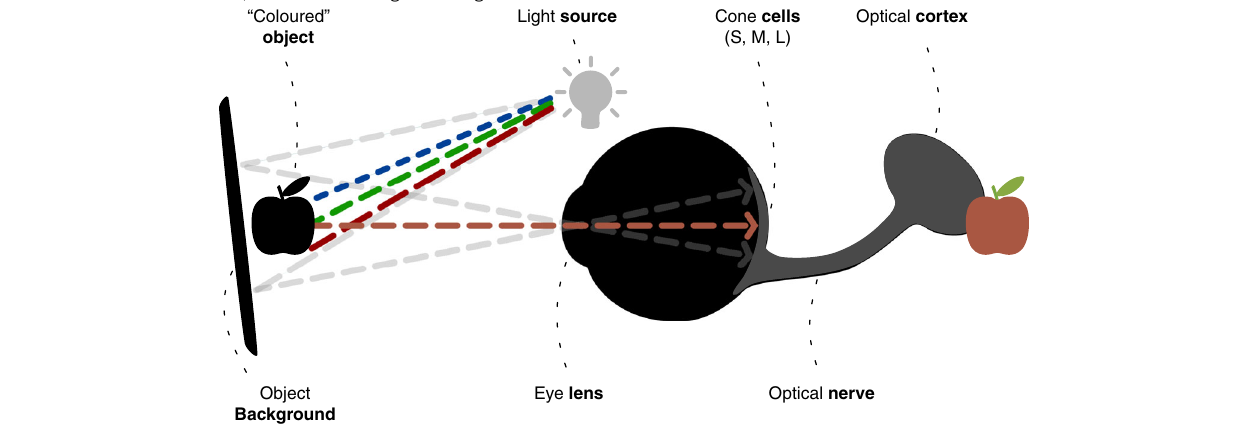
Box Fig. 1: Simpli fi ed schematic of human colour perception . The perception of a certain colour, or colour gradient, by the optical cortex depends not only on the optical properties of the object, but also on the optical properties of both light source and object background, and the eye ’ s light receptors (rod and cone cells for short, medium and long